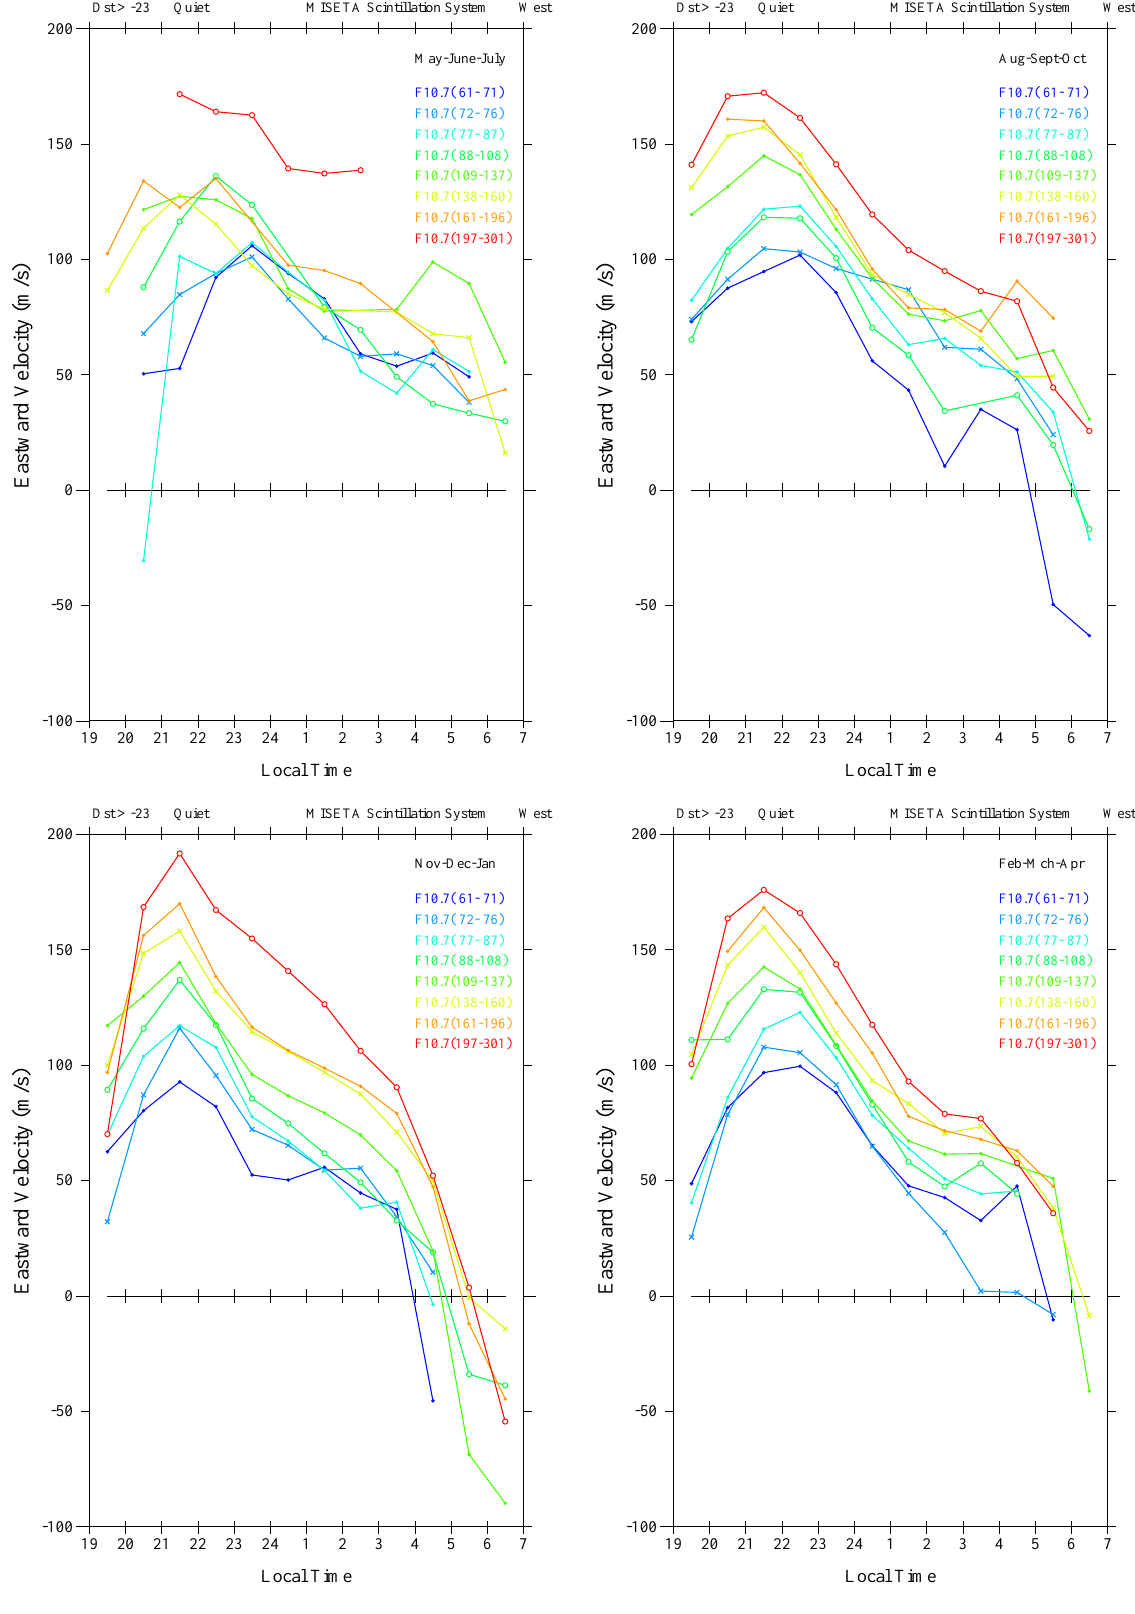
Fig. 5. (b) Seasonal average zonal drifts for Ancon-W, quiet D st ( > −